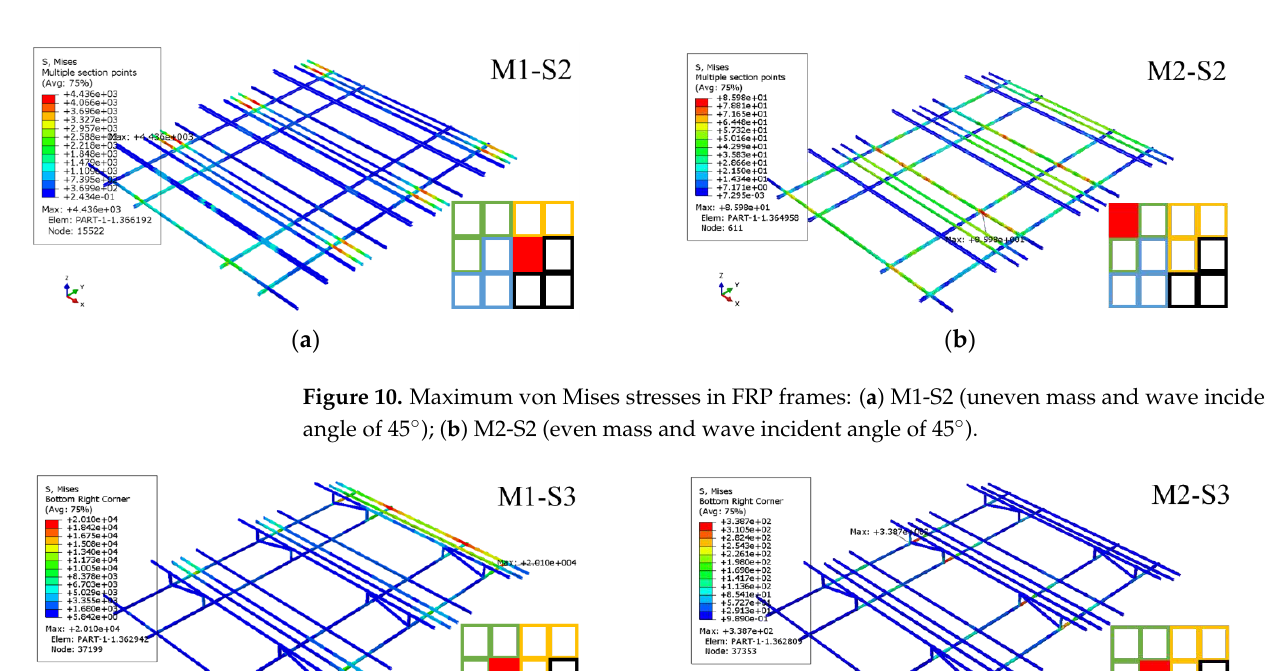
( b ) ( c ) Figure 9. Stress distribution for the case M2-S1 (even mass and wave incident angle 0°): ( a ) normal stress; ( b ) shear stress; ( c ) von Mises stress. The maximum von Mises stress in the FRP structure was reduced from 4436 MPa to 86 MPa after the even mass distribution (refer to Figure 10). The solid red cells in Figure